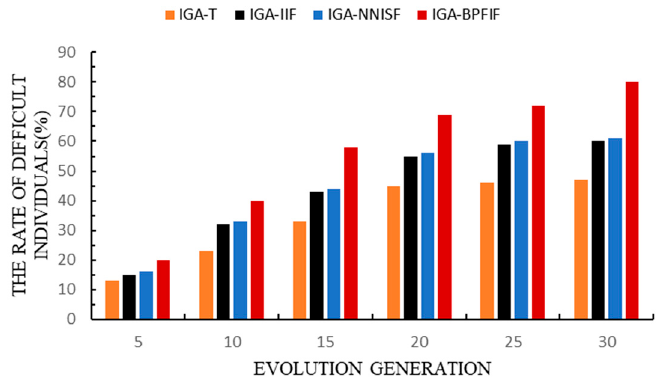
Figure 7. Comparison of the number of different individuals.